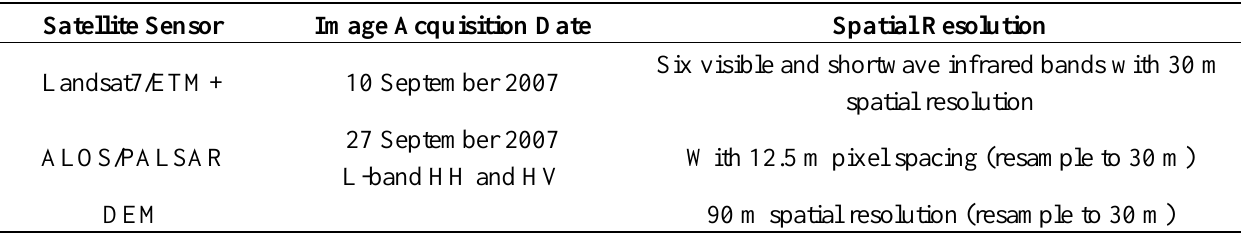
Table 2. Remote sensing data used in this study.